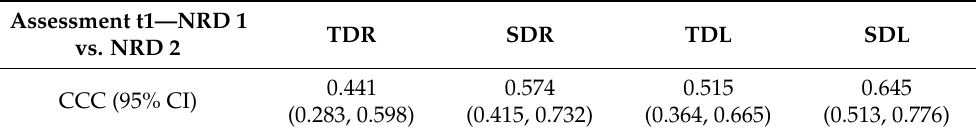
Table 4. Inter-rater agreement in ONSD MRI assessment between the two neuroradiologists in the first assessment (assessment t1, NRD 1 vs. NRD 2). Inter-rater agreement comparing the first MRI assessment of the two